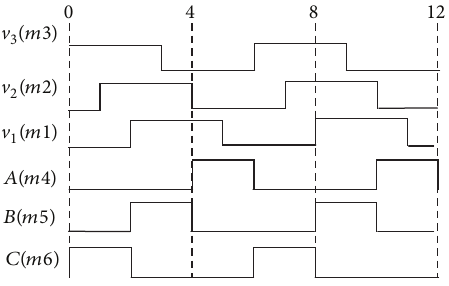
Figure 3: A 3-stage johnson counter